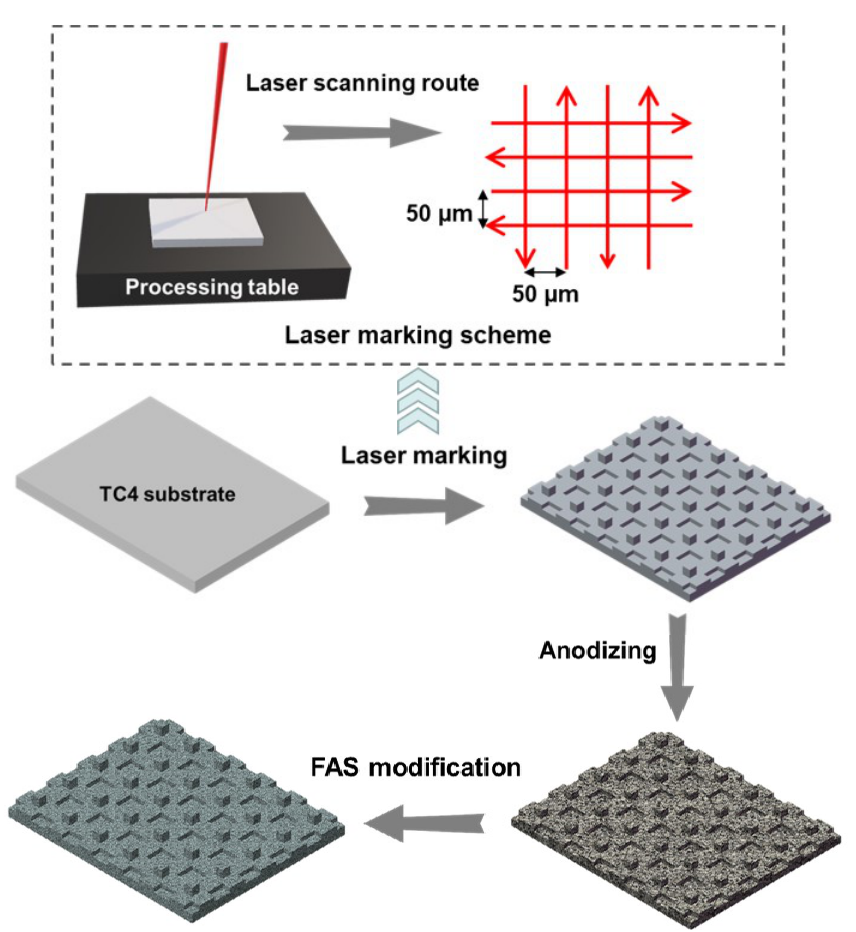
Figure 1. Preparation pathway (i.e., laser marking, anodizing, and FAS modification) for the superhy- drophobic surface on TC4 alloy